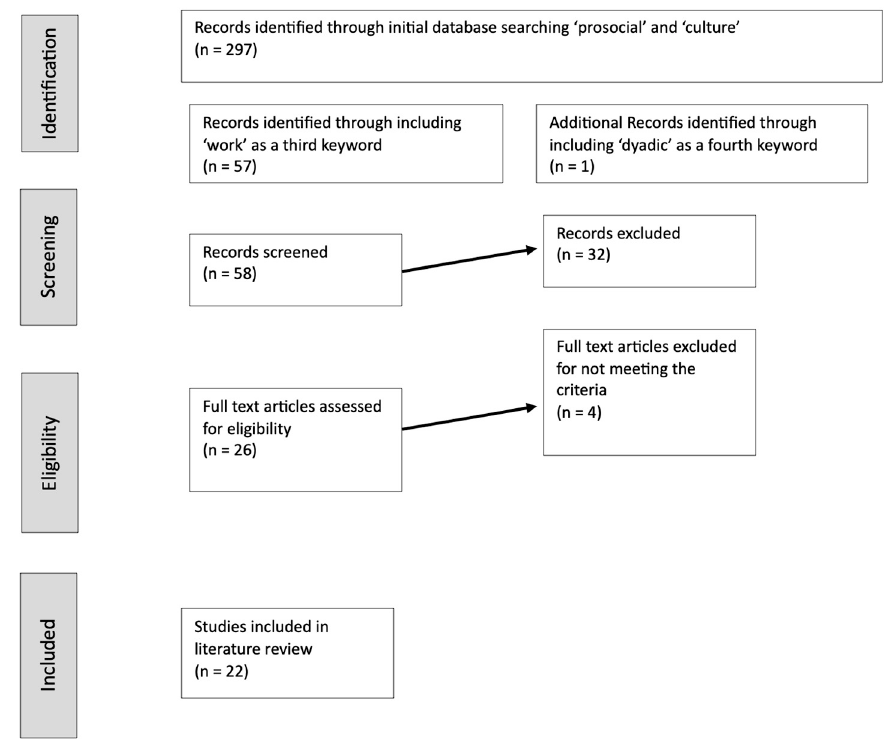
Figure 1. Literature Review Flow Chart.